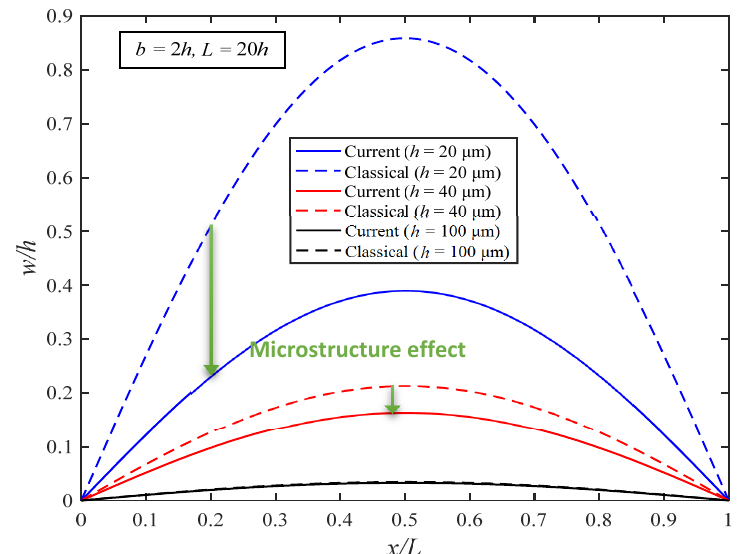
Figure 4. Deflection of the MEE-FGM simply supported beam (Gradient index n = 5).